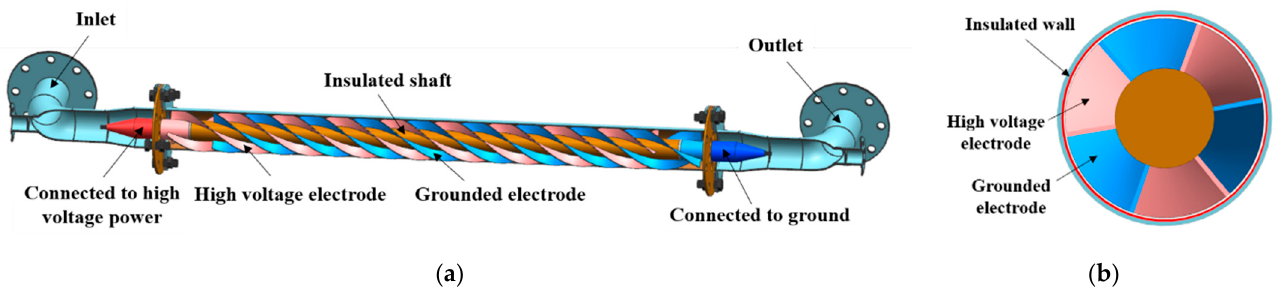
Figure 1. Structure of compact electrostatic coalescer with helical electrodes. ( a ) 3D assembly model ; ( b ) cross-section view of the assembly .